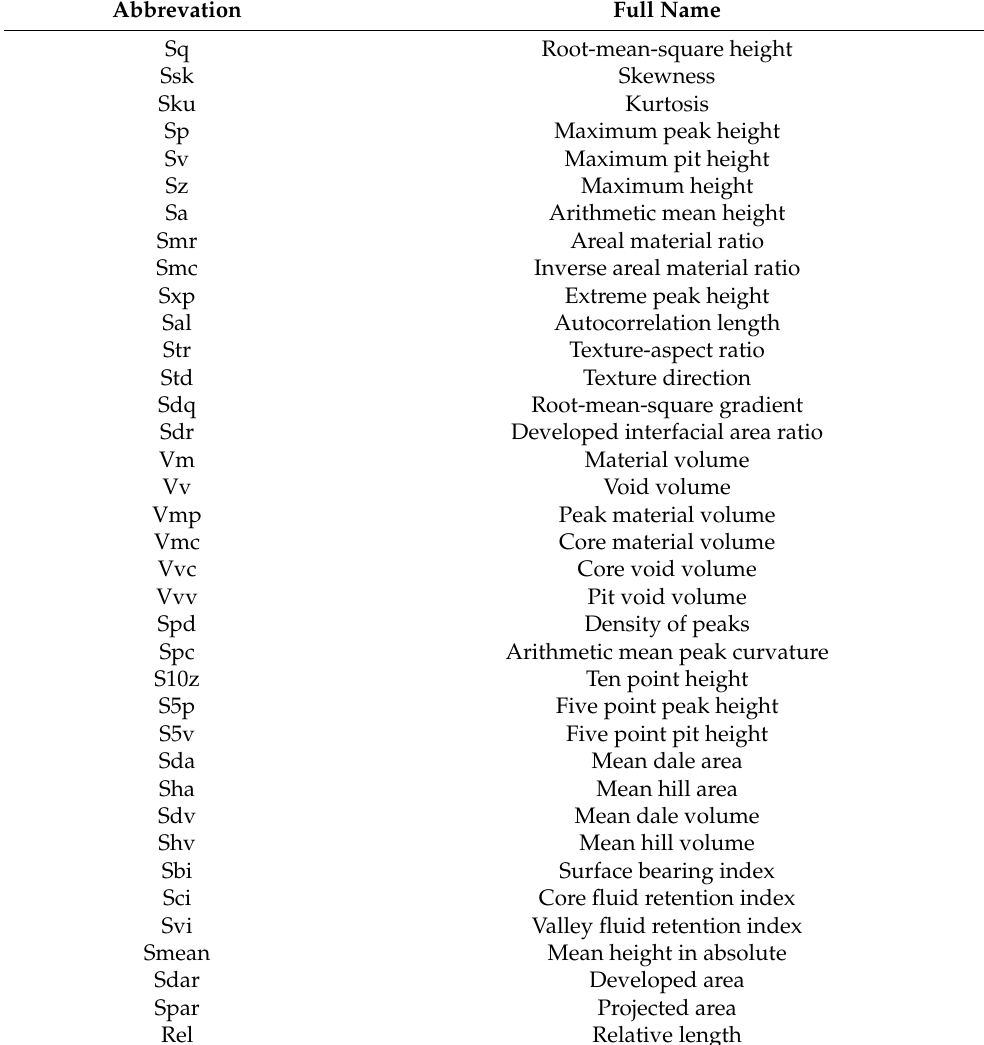
Table A1. Abbreviations of surface characterization parameters and their full